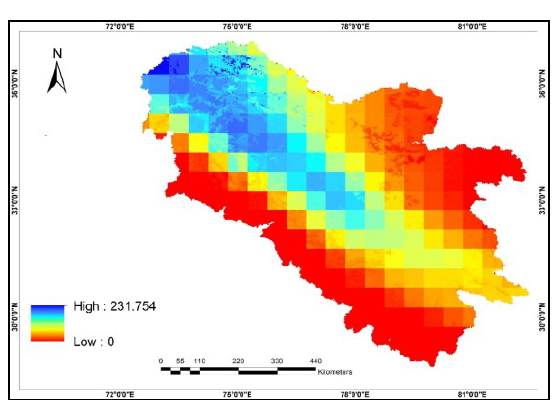
Figure 16. SD (in cm) map for NWH river basins.